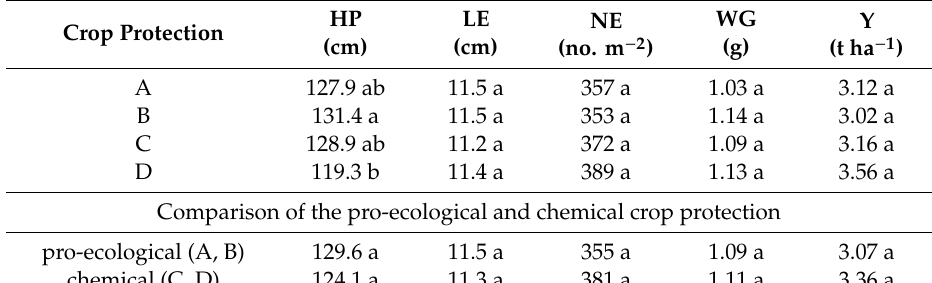
Table 6. The impact of crop protection system on selected yield components and grain yield of the spelt wheat cv. “Schwabenspelz” (mean for 2013–2015). HP—height of plant, LE—length of ear, NE—number of ears per m 2 , WG—weight of grains per ear, Y—yield for the crop protection methods A–D. HP Crop Protection (cm)